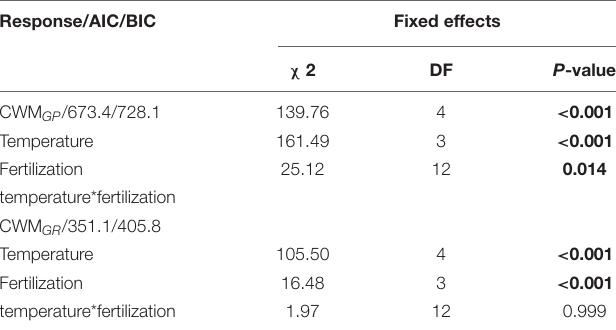
TABLE 3 | Results Generalized linear mixed model (GLMM) testing the effect of temperature (tem), fertilization gradient (fer) and their interaction on community weighted mean of germination percentage (CWM GP ) and of germination rate (CWM GR